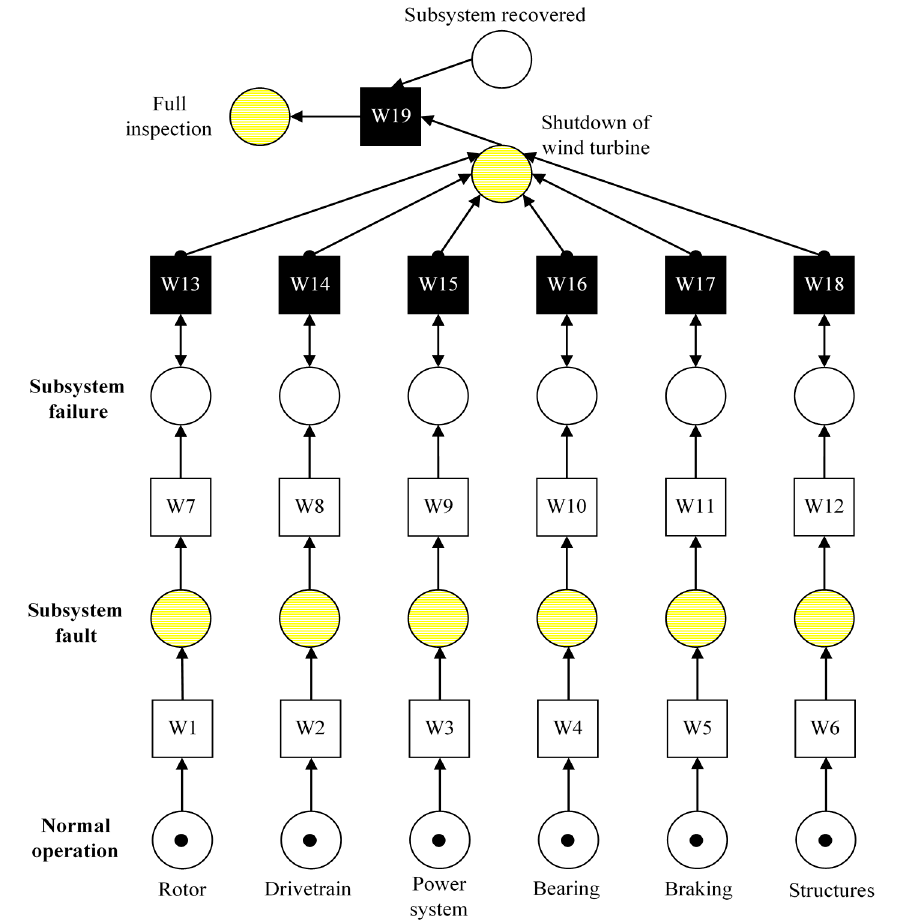
Figure 5. System Petri Net